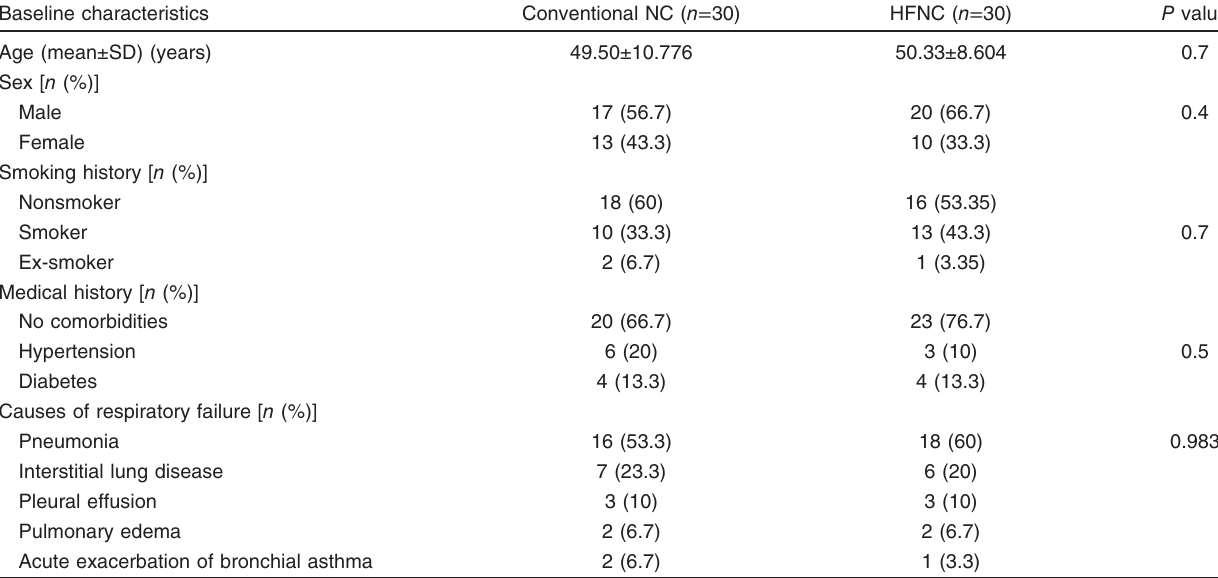
Table 1 Baseline characteristics in the two studied groups Baseline